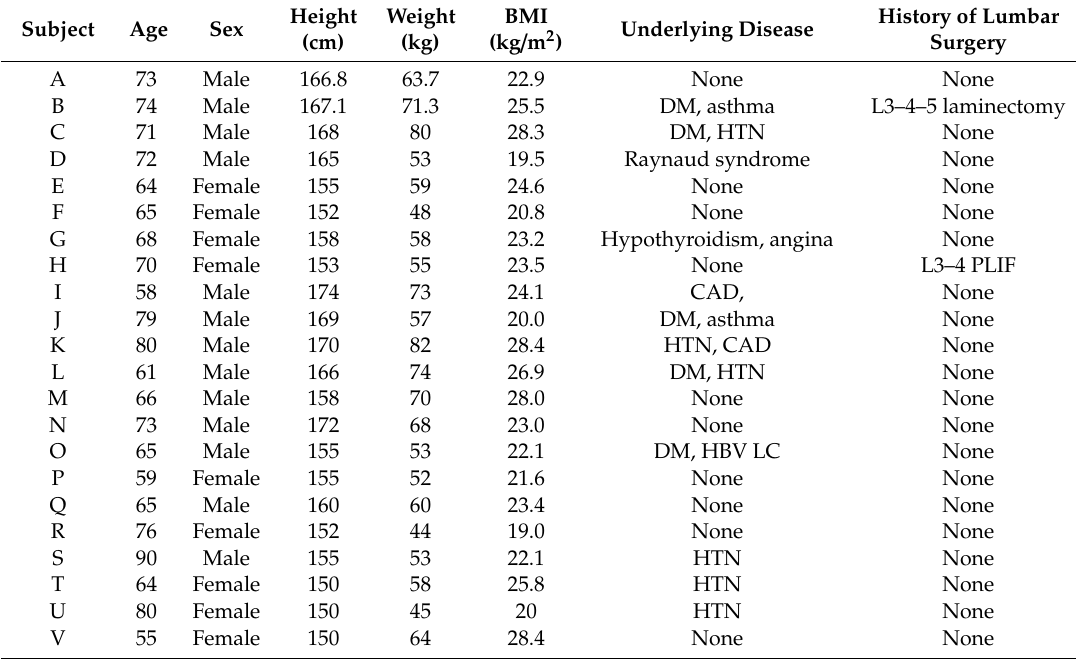
Table 1. Demographic characteristics of the study